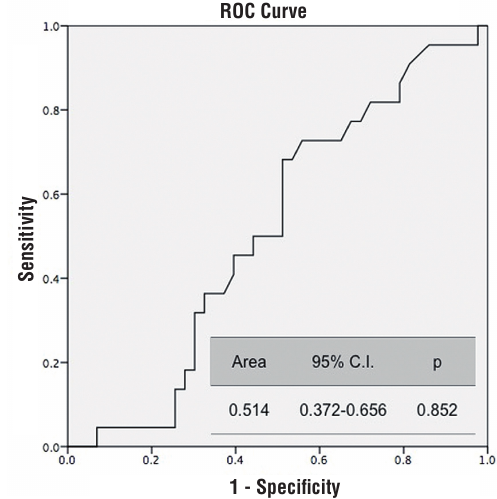
figure 1 - NLR predictive probability of the malignancy. figure 2 - NLR predictive probability of tumor